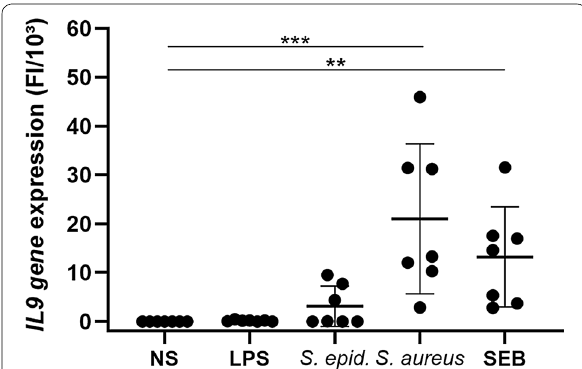
Fig. 2 S. aureus induced IL9 gene expression in PBMCs. Levels of IL9 gene expression in PBMCs after 24 h stimulation with culture